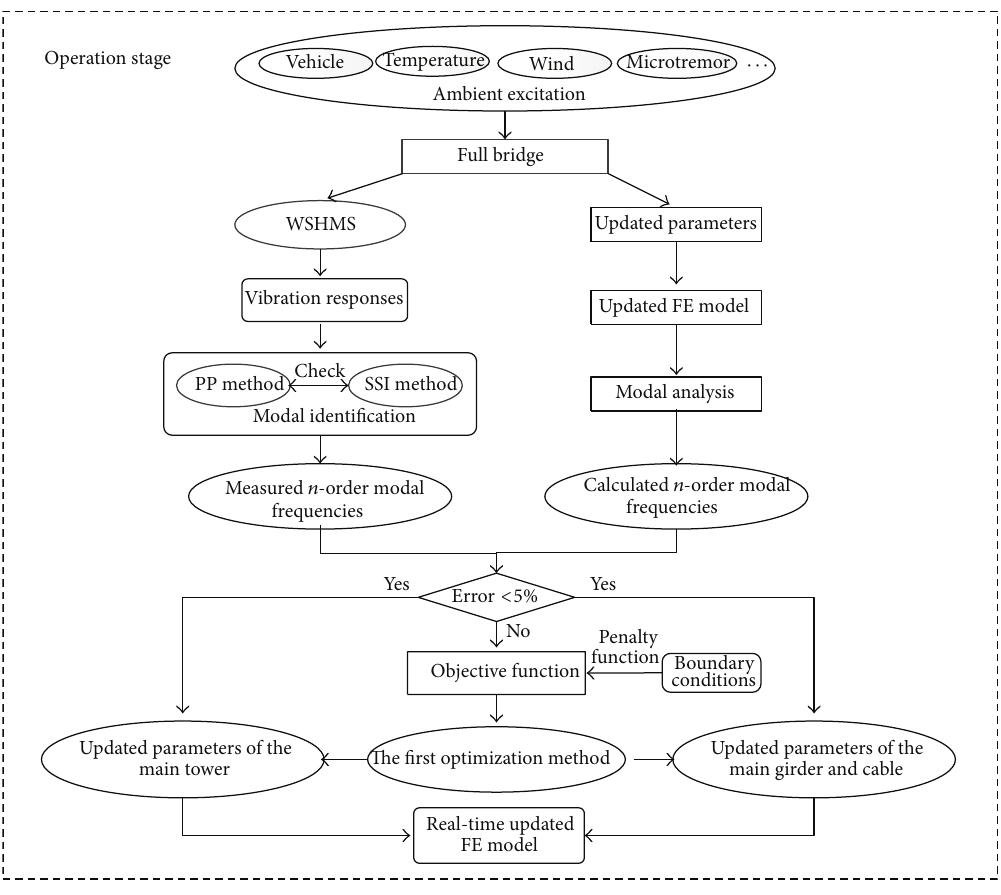
Figure 13: FE model updating of the operation